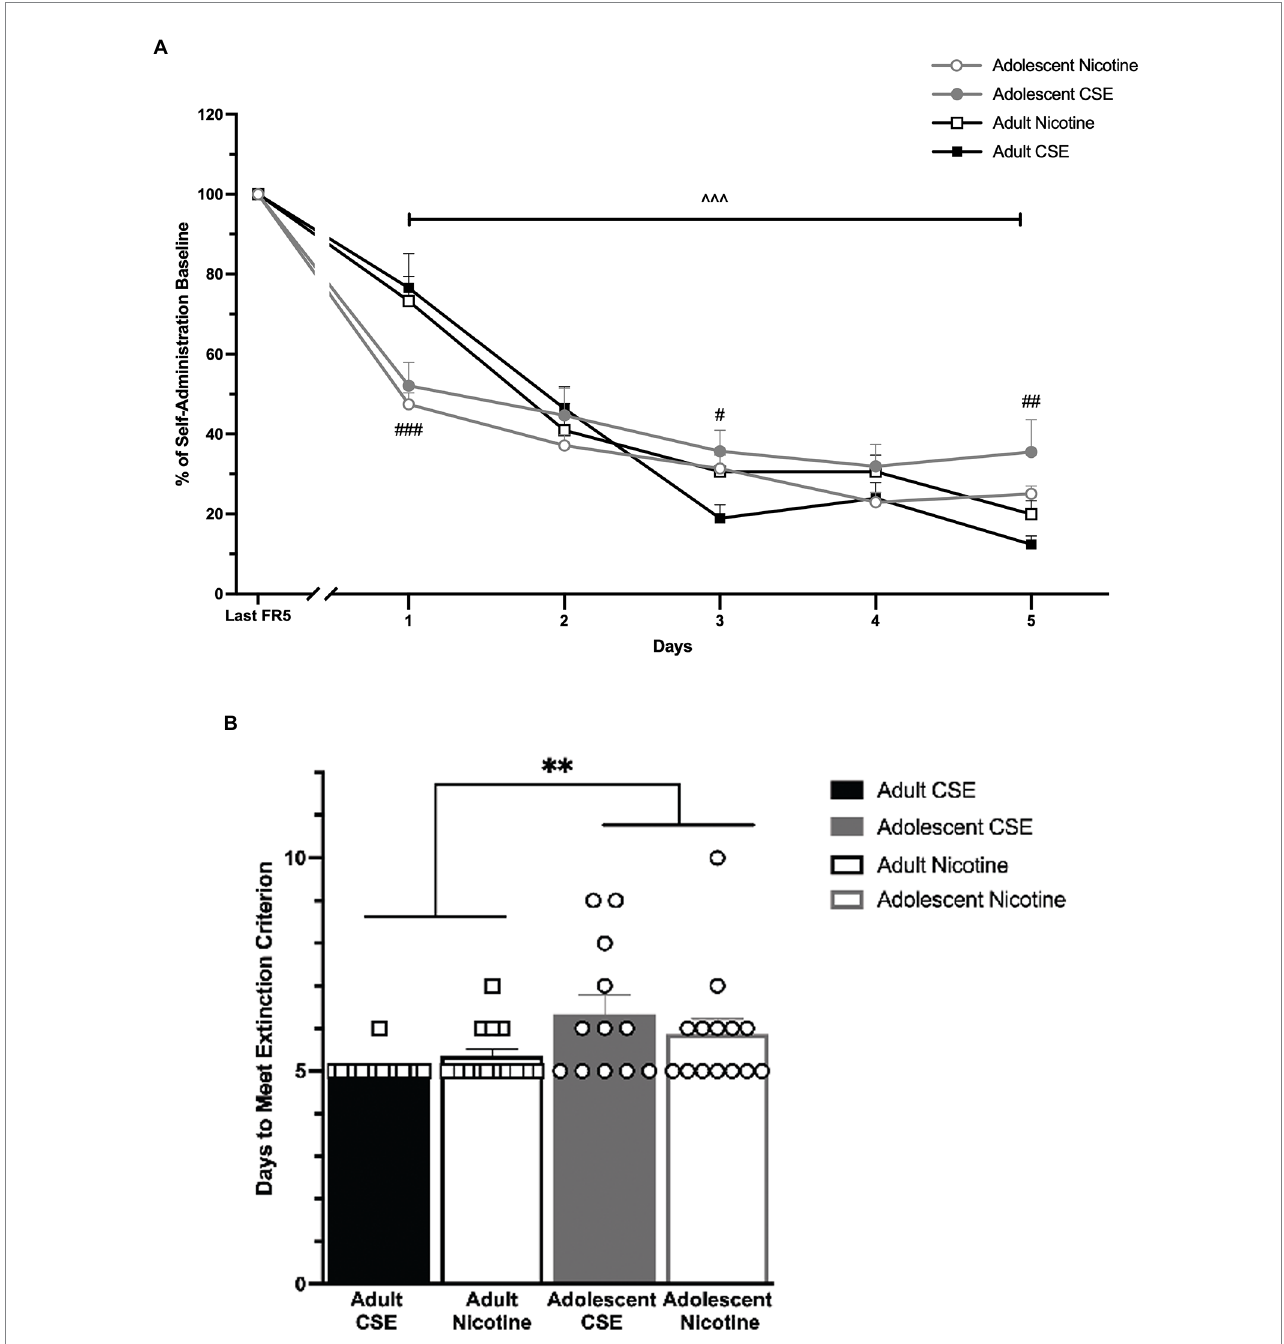
FIGURE 4 Age differences in extinction of responding. (A) The lines represent mean (±SEM) responding as a percentage of their last self-administration day for adolescent (gray lines) and adult (black lines) rats, which had previously self-administered nicotine or CSE. Drugs were collapsed. Open circles and open squares represent nicotine; closed circles and closed squares represent CSE. +++ p < 0.0001 vs. Last FR5. ### p < 0.0001, ## p < 0.01, # p < 0.05 vs. adult. n = 12–15 per group. (B) Days to meet extinction criterion. The bars represent mean (±SEM) days to meet extinction criterion in adolescents and adult of rats that self-administered CSE and nicotine. ** p < 0.001 adults vs. adolescents. n = 12–15 per